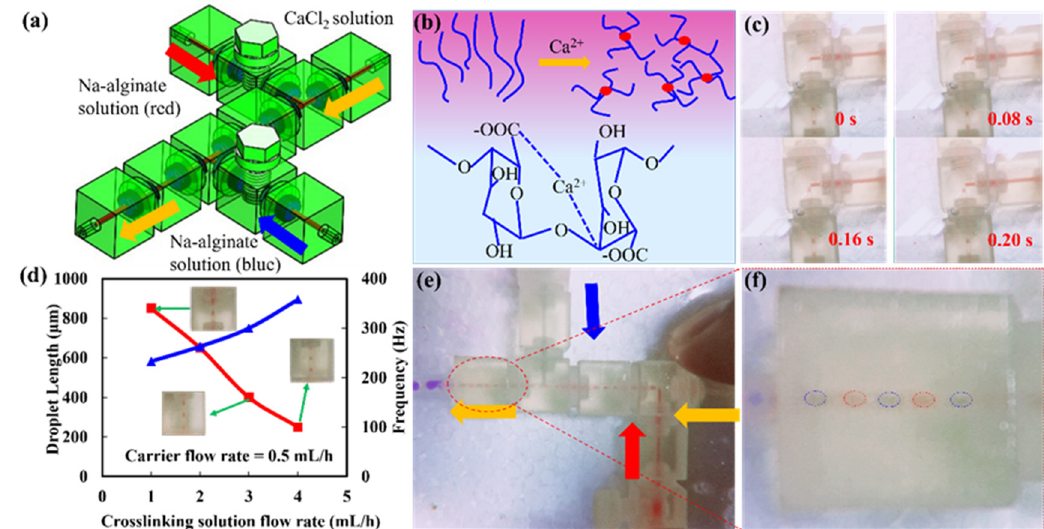
Figure 6. ( a ) modular microfluidic system for droplet generation. ( b ) Ca 2+ cross-linking to prepare sodium alginate gel microspheres. ( c ) diagram of microsphere generation process. ( d ) the relationship between the length of the gel microspheres and the flow velocity, and the relationship between the flow velocity and the frequency of microsphere generation. ( e ) images of double emulsions. ( f ) Images of double emulsions.